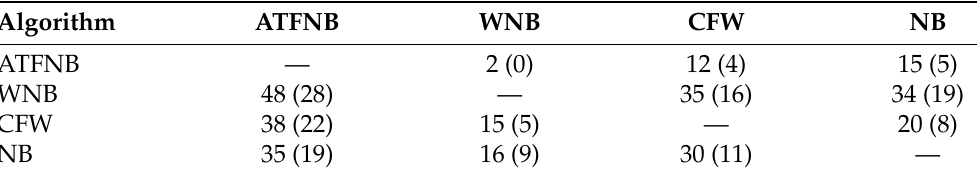
Table 6. Summary of two-tailed t -test results of classification accuracy with regard to ATFNB on UCI